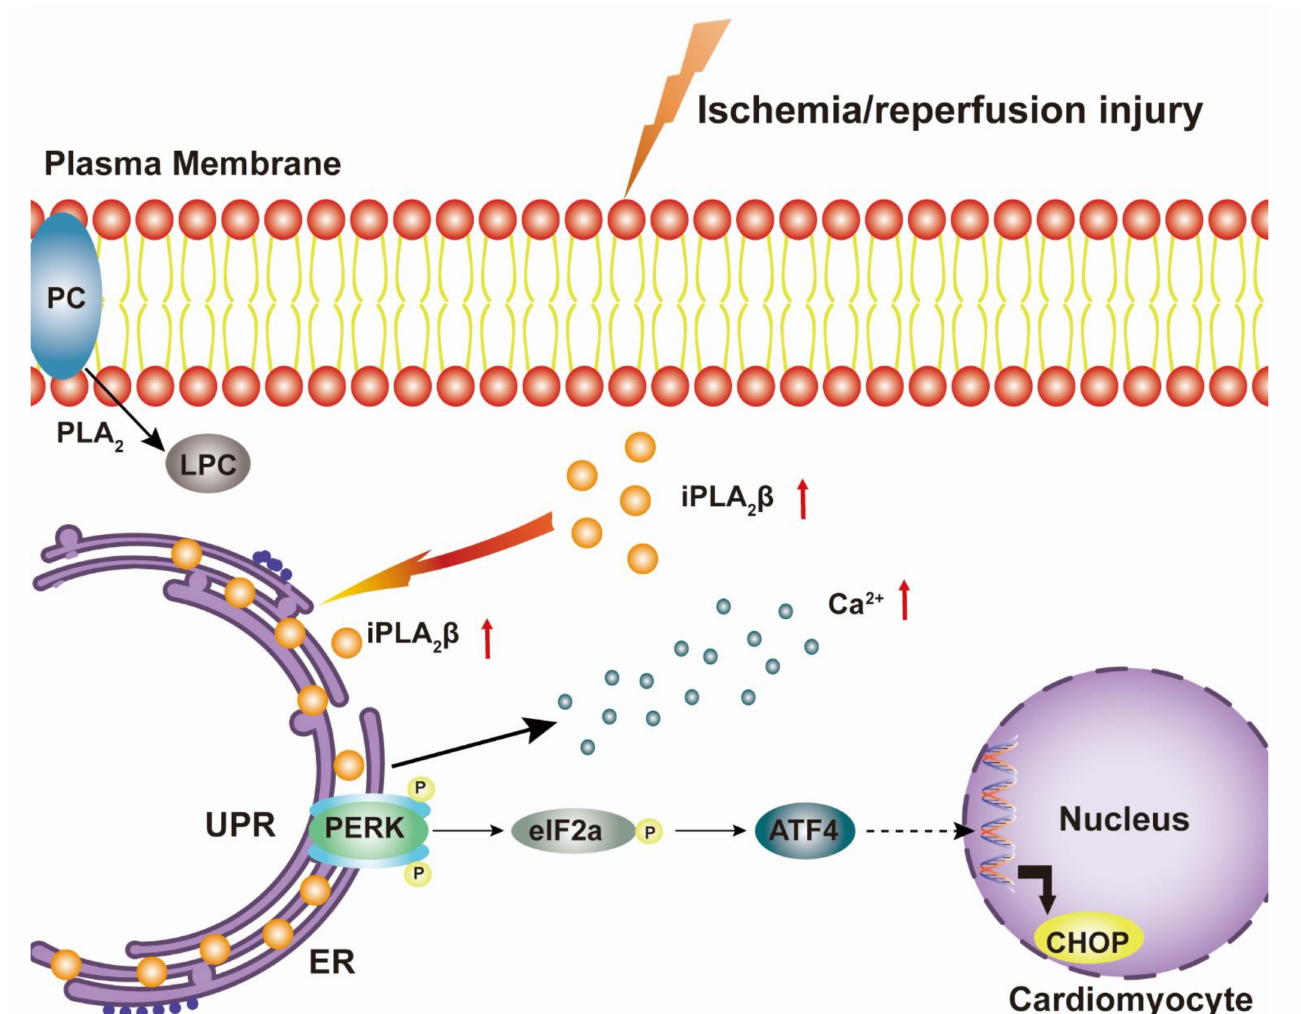
Figure 7. Illustration of the role of iPLA 2 β on ER stress in cardiomyocyte upon I//R. PLA 2 expression is up-regulated in cardiomyocyte after I/R, which consequently leads to an increase of phosphatidylcholine (PC) metabolism. The generation of LPC is elevated and cardiomyocyte damage is augmented. The protein level of intracellular iPLA 2 β , one of the PLA 2 enzymes, is upregulated. The increased iPLA 2 β translocates to the ER and induces ER stress, which further leads to apoptosis through the PERK/ATF4/CHOP pathway. Additionally, iPLA 2 β may also increase intracellular calcium flow in